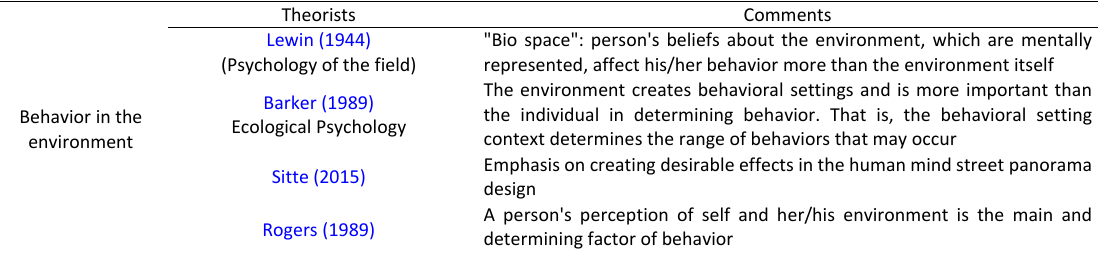
Table 3: Theories of behavior in the environment